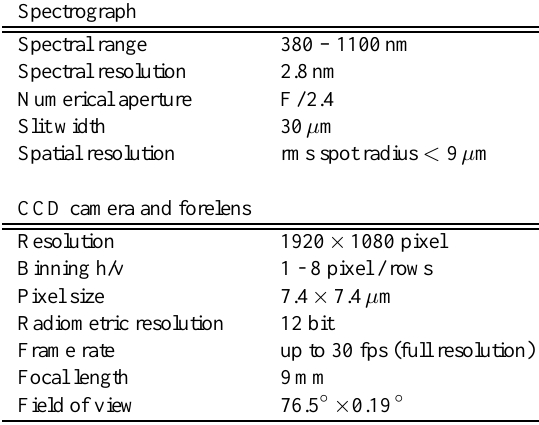
Table 2: Specification of the hyperspectral imager